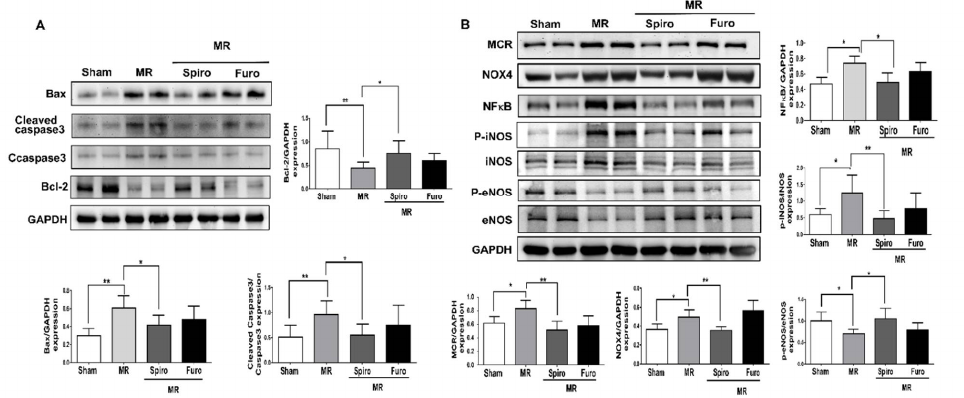
Figure 5. Mineralocorticoid receptor (MCR) antagonists attenuate suppressed mitral regurgitation (MR)-induced cardiomyocyte apoptosis associated with the MCR/NOX4/ROS pathway. ( A ) Representative and quantified apoptosis-associated proteins, including Bax, Bcl-2, and cleaved caspase 3, in the indicated groups of rats. ( B ) Representative quantification of ROS-associated proteins, including MCR/NOX4/NF κ B/iNOS/eNOS, in the indicated groups of rats. Data are expressed as the mean ± standard deviation (S.D.). * p < 0.05 and ** p < 0.01 for differences from each